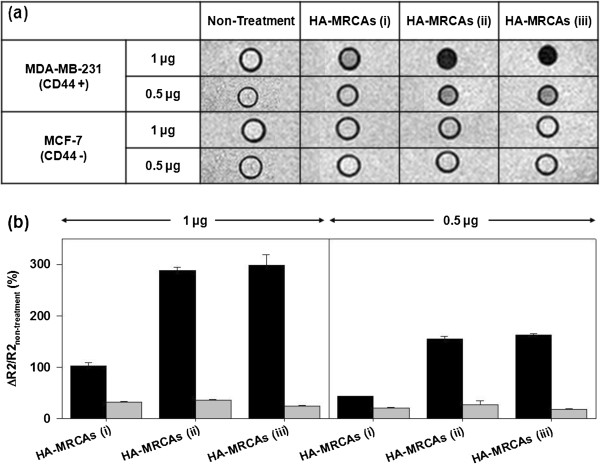
MR images and graph of Δ R 2/ R 2non-treatment. (a) T2-weighted MR images and (b) the graph of ΔR2/R2non-treatment of MDA-MB-231 (black bar) and MCF-7 (gray bar) after HA-MRCA treatment versus untreated cells at 1 and 0.5 μg of metal (Fe + Mn) concentrations.